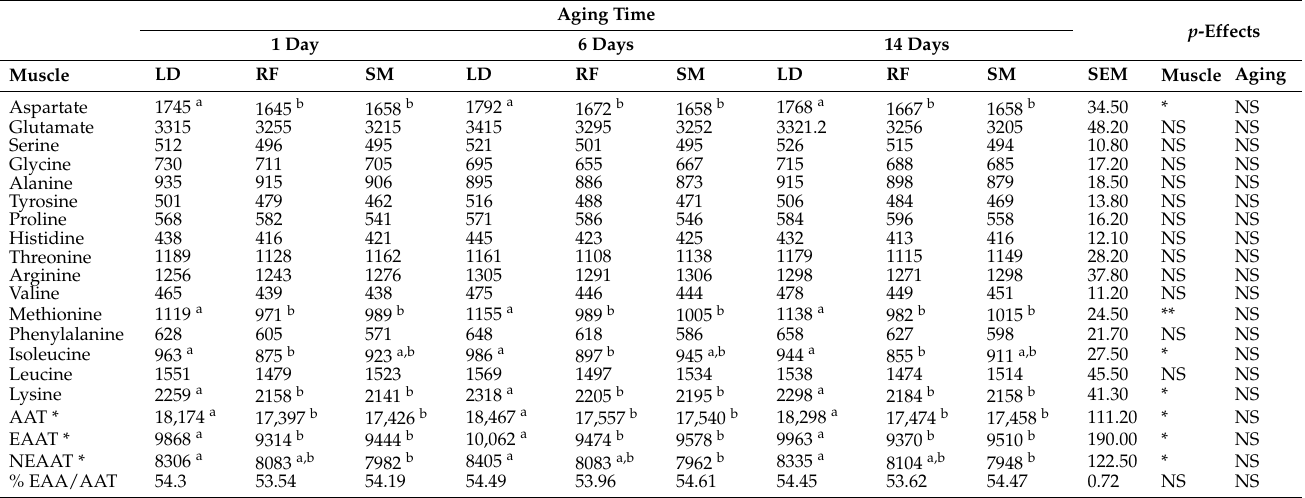
Table 5. Effect of muscle and aging time (days) on amino acids content (mg/100g of meat) of meat from donkey (means ±